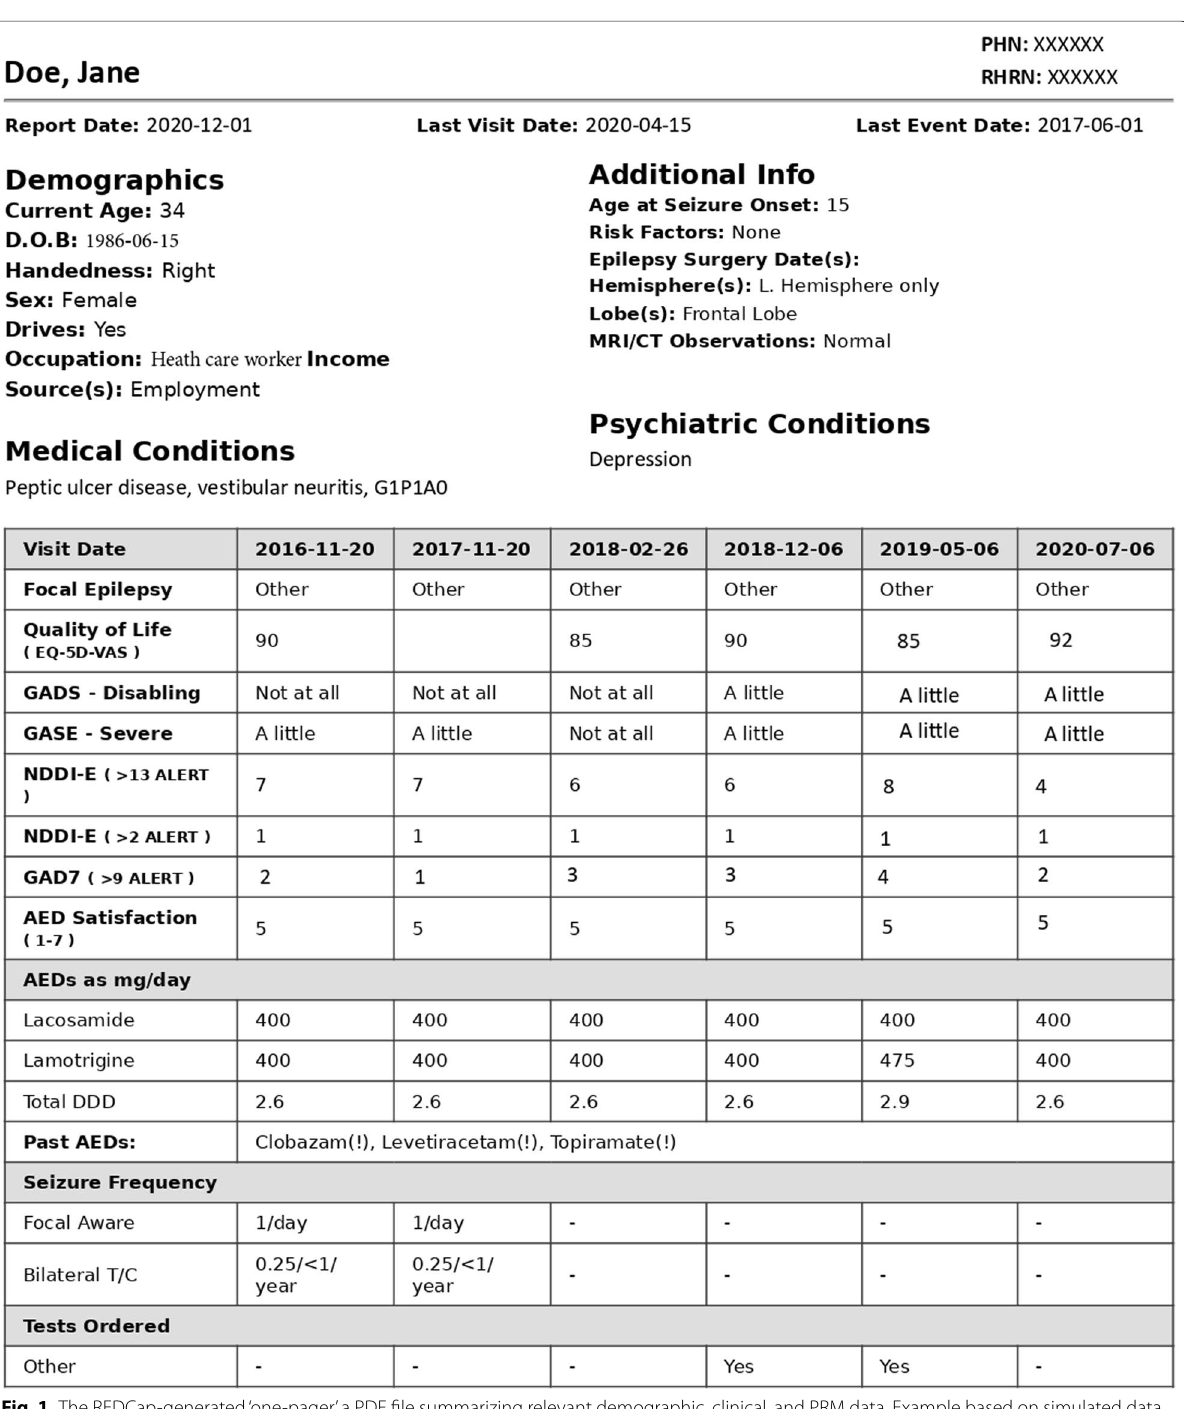
Fig. 1 The REDCap‑generated ‘one‑pager,’ a PDF file summarizing relevant demographic, clinical, and PRM data. Example based on simulated